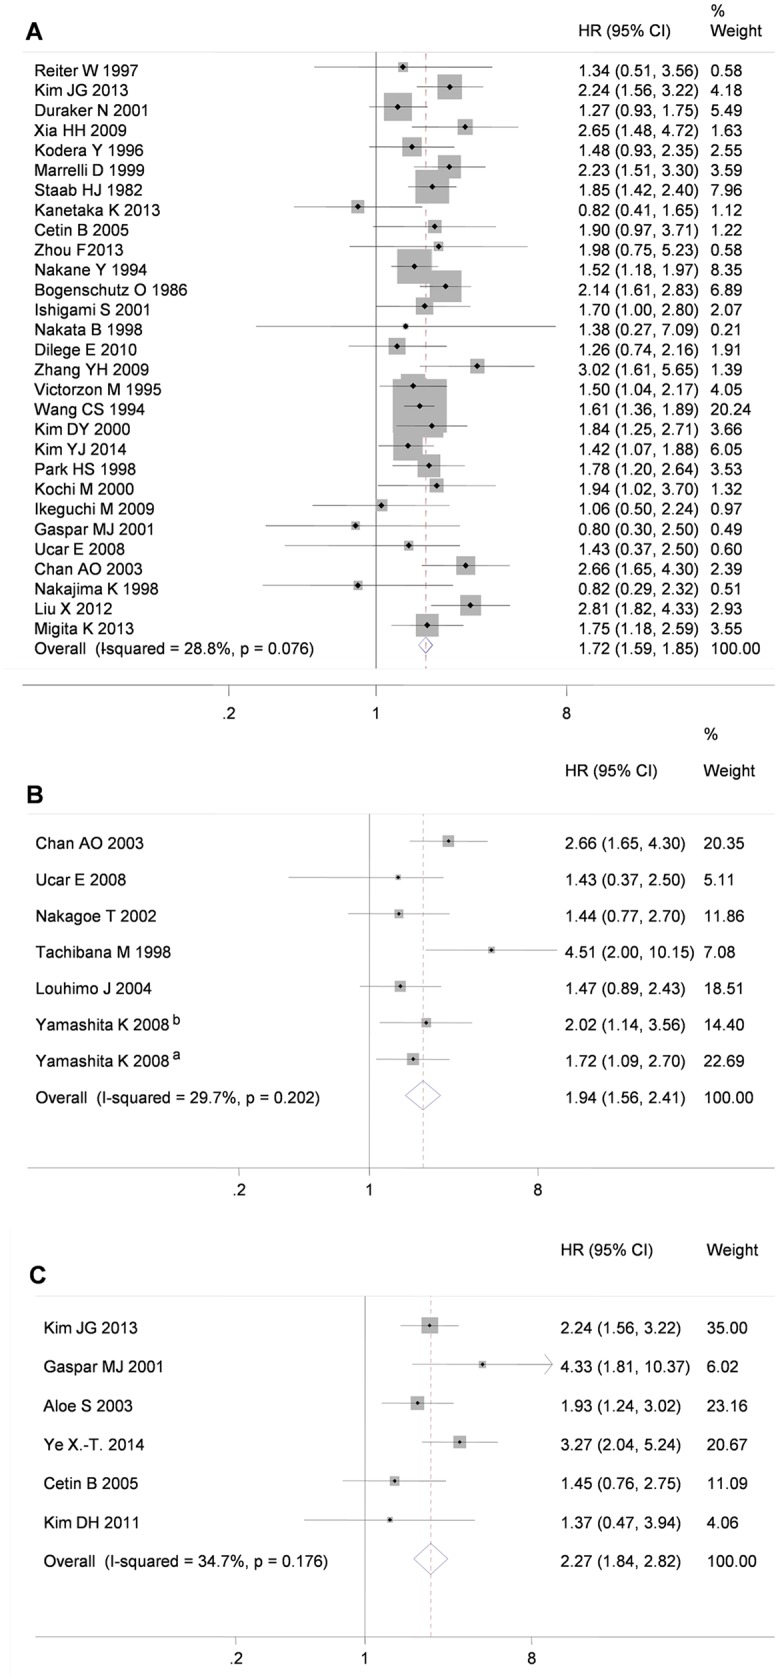
Forest plots for OS (A), DSS (B) and DFS (C) in the CEA+ patients with gastric cancer relative to the CEA- patients are shown.
a, Prospective research; b, Retrospective research; The I
2 was used to assess the proportion of total variation in the estimated HRs that was due to between-study heterogeneity. A fixed-effects model was applied for the pooled analysis.